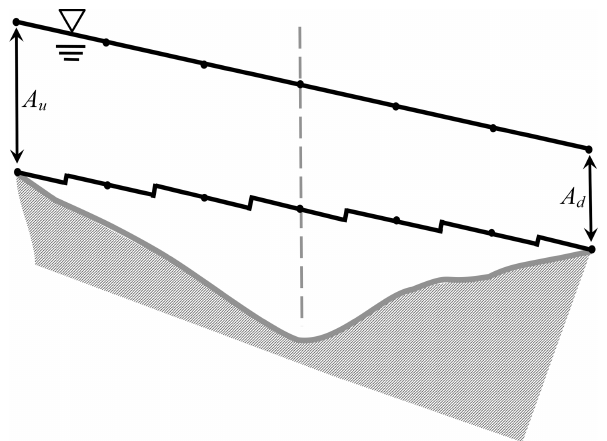
Figure 8. Approximated finite-element cross-section characteristics using λ(x) = L − 1 e for non-monotonic topography in Fig. 7. The dashed gray line is where the cross-section area reverses from in- creasing to